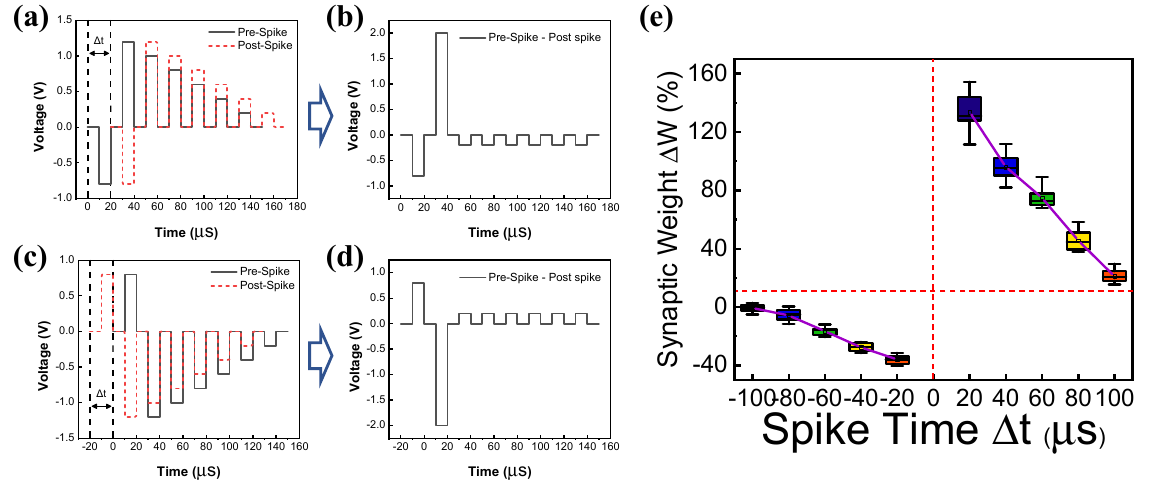
Figure 6. ( a ) Pulse schemes of pre-spike (black line) and post-spike (red line). ( b ) Pre-spike occurs before post-spike by Δ t, causing the overlapped pulse for potentiation. ( c ) Pulse schemes of pre-spike (black line) and post-spike (red line). ( d ) Pre-spike occurs after post-spike by Δ t, causing the overlapped pulse for depression. ( e ) Synaptic weight change as a function of spike time for STDP emulation.